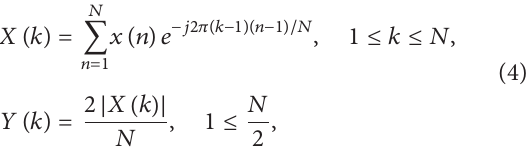
function 𝑈(𝑥) is determined by the initial conditions and never changes. Only in the presence of the periodic input signal can the potential barrier be reduced and the particle, which stays in one potential well, may surmount the energy barrier and enter another potential well. In fact, the nonlinear system output 𝑥(𝑡) is the Brownian particle trajectory in the potential function 𝑈(𝑥) under the interaction of the periodic input signal and the